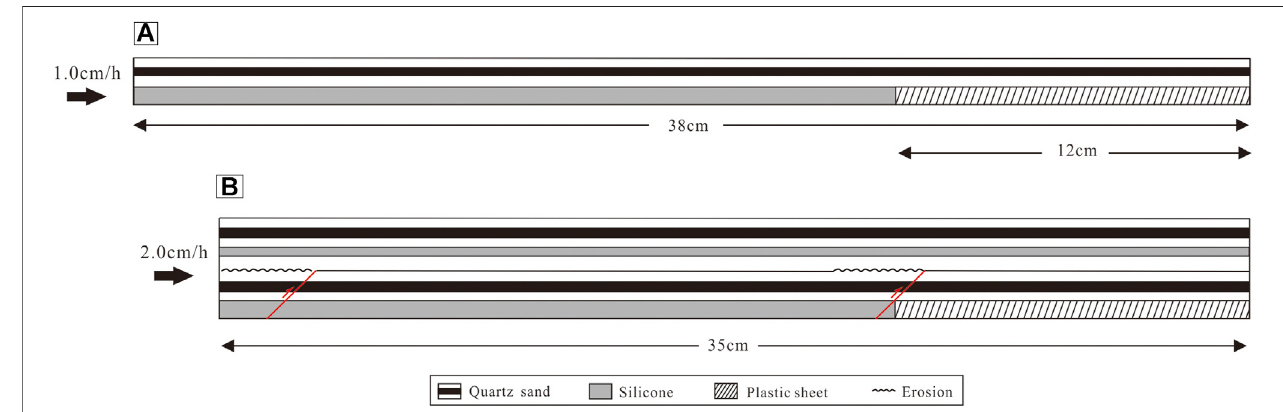
FIGURE 8 | Diagram of the model setup with two stages of shortening. (A) : In the fi rst stage, the shortening amount was 3 cm at the rate of 1.0 cm/h. (B) : In the second stage, folds generated in the fi rst stage were eroded, and then sand and silicone were added before shortening at the rate of 2.0 cm/h.